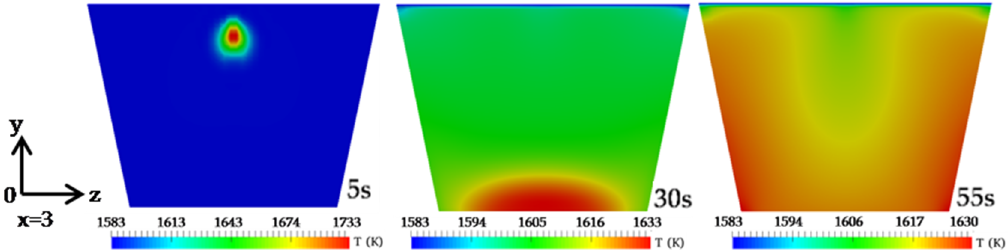
Figure 8. Temperature distribution of the center plane (cf. Figure 3a) at 5, 30, 55 and 80 s. Processes 2020 , 8 , x FOR PEER REVIEW